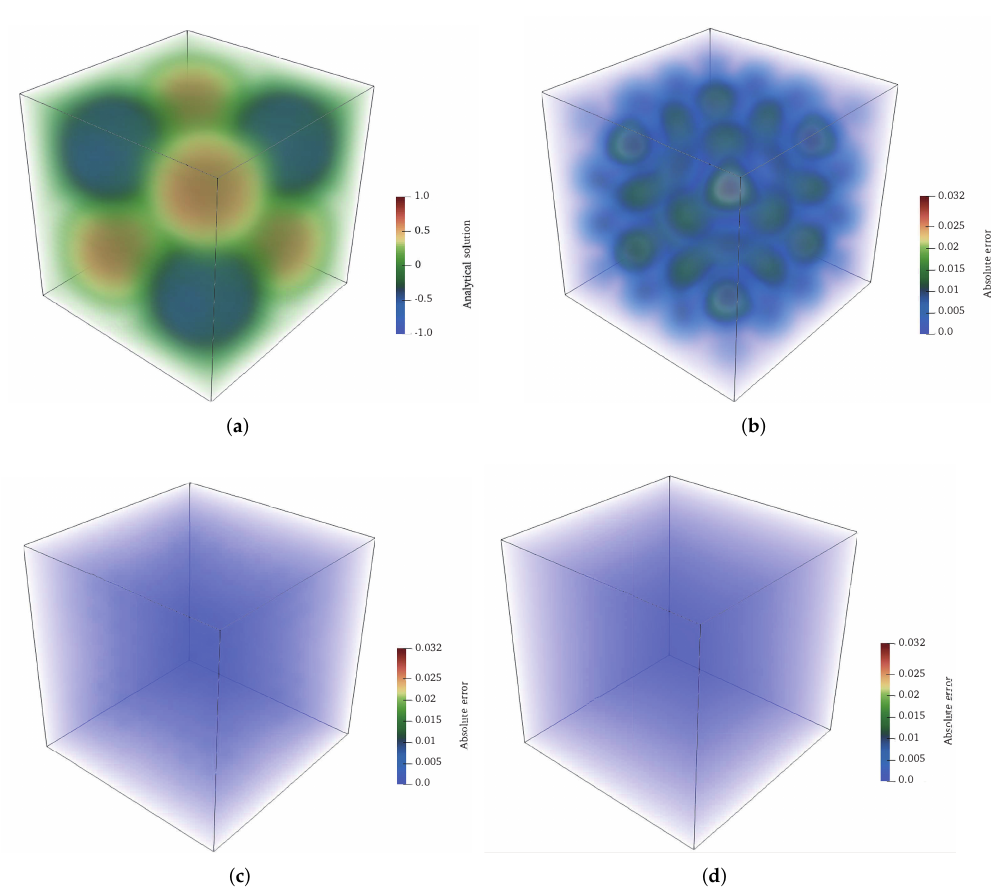
Figure 6. Comparison of the absolute error between the numerical and analytical solutions after each knot refinement. ( a ) Analytical solution. ( b ) n = 7 × 7 × 7, absolute error = 0.032. ( c ) n = 11 × 11 × 11, absolute error = 0.002. ( d ) n = 19 × 19 × 19, absolute error = 4.743 × 10 − 4